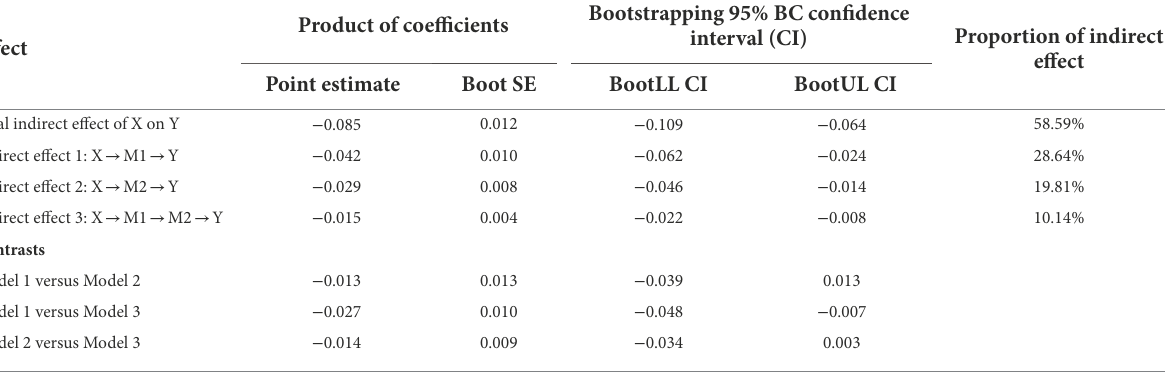
TABLE 4 Comparison of indirect effects of organizational support on insomnia mediated by psychological capital and overcommitment.